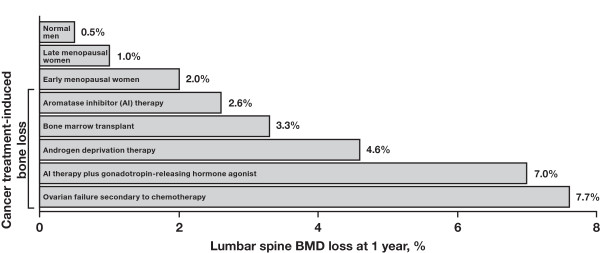
Cancer treatment-induced bone loss occurs at higher rates than age-related bone loss. Reprinted with permission from Guise TA [16].